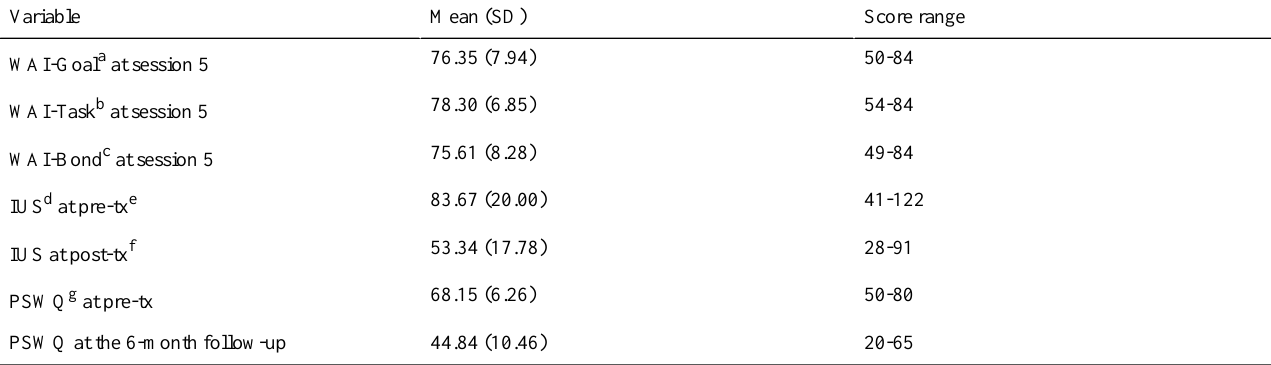
Table 1. Descriptive statistics for all study measures during cognitive behavioral treatment for generalized anxiety disorder delivered by videoconference